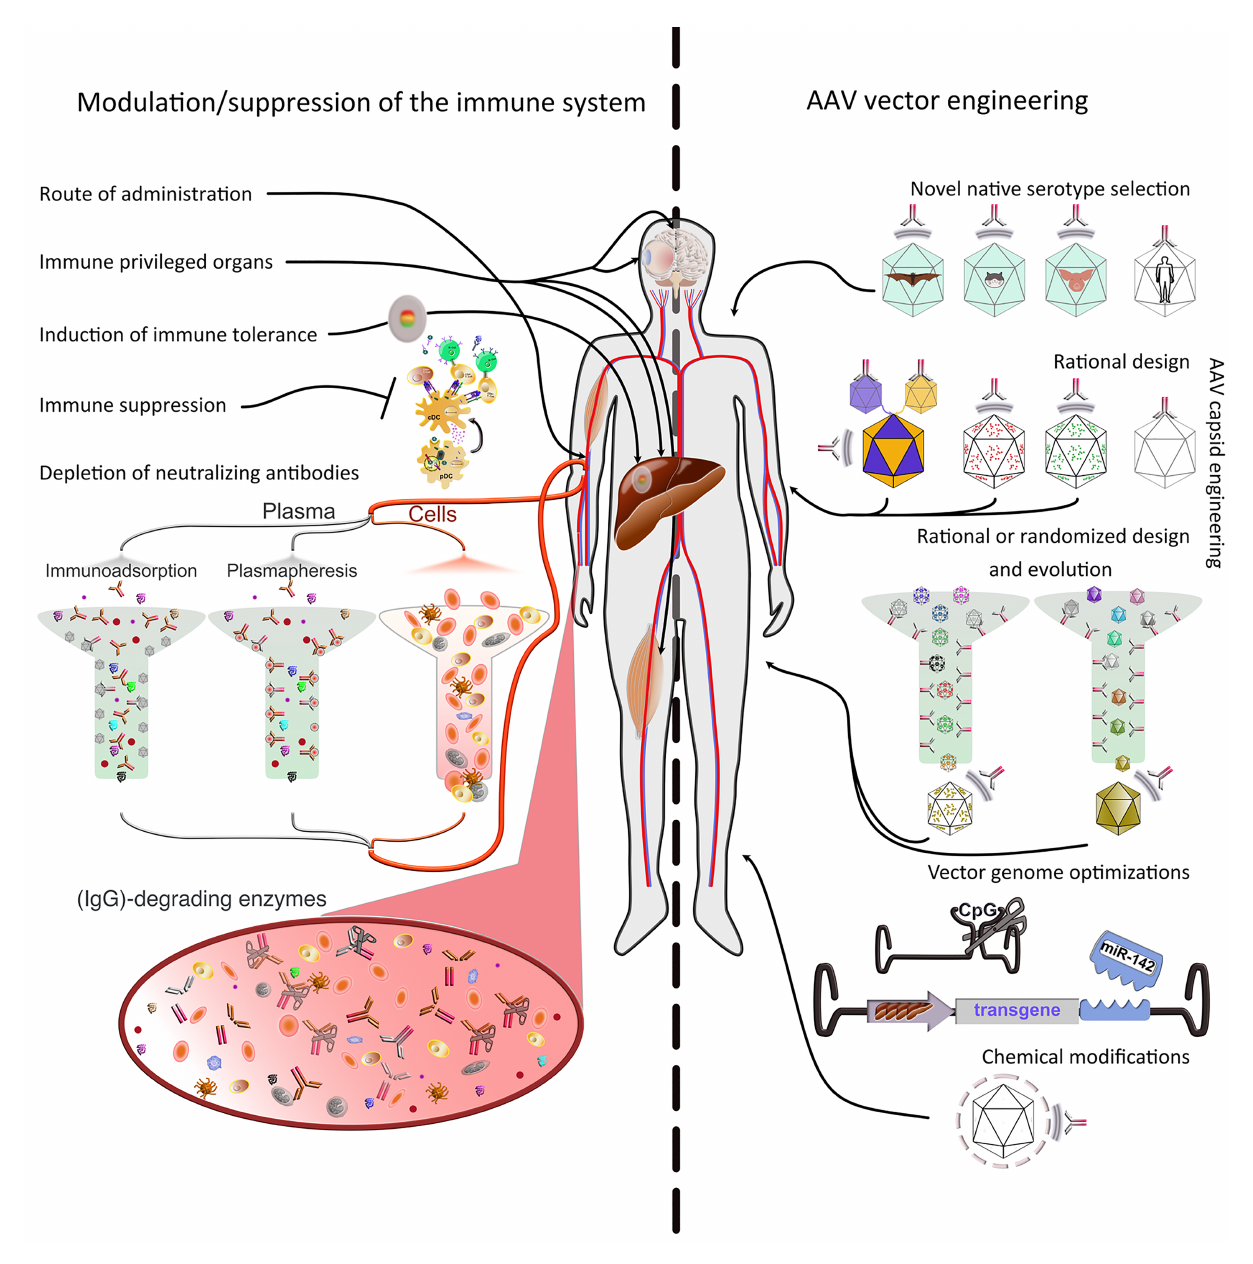
FIGURE 2 | Strategies to evade immune responses. Several approaches to evade immune responses have been applied in the clinic or explored on a basic research level. They can be roughly divided into two main classes, i.e ., 1) modulation or suppression of the subject ’ s immune system and 2) AAV vector engineering. 1) Modulation/ suppression of the immune system. The route of administration is decisive in evading pre-existing immunity. Targeting immune-privileged organs, when possible, provides protection not only by evading immune responses, but also by inducing regulatory responses. The latter can also be induced through multiple exogenous interventions. Additionally, pharmacological immune suppression has been used extensively in the clinic. Pre-existing immunity (nAbs) is particularly dif fi cult to evade or suppress. Promising approaches include plasmapheresis or the use of immunoadsorption columns ex vivo after separation from the cellular parts of the blood. Furthermore, recent studies have used IgG-degrading enzymes in vivo . 2) AAV vector engineering. The use of native serotypes from species other than humans or NHPs, or engineering the capsid of existing serotypes (predominantly from primate species) are advantageous strategies to evade immunity. The current serotypes can be modi fi ed in de fi ned positions (rational design) based on acquired knowledge about sequence-structure-function relationships. To increase variability, the rational design strategy can be used to generate libraries, which then can be evolved/selected ex or in vivo . Libraries can also be fully randomized and interrogated for multiple properties, not only immune evasion. Moreover, the viral genome can be optimized to minimize antigen presentation (e.g., via cell-type speci fi c promoters, miRNAs to prevent expression in APCs or peptides to inhibit antigen presentation) or immune system induction (CpG depletion). Finally, the capsid can be protected from the immune system by coating with molecules, such as PEG, engulfment in exosomes, or display of immune evasion peptides on its